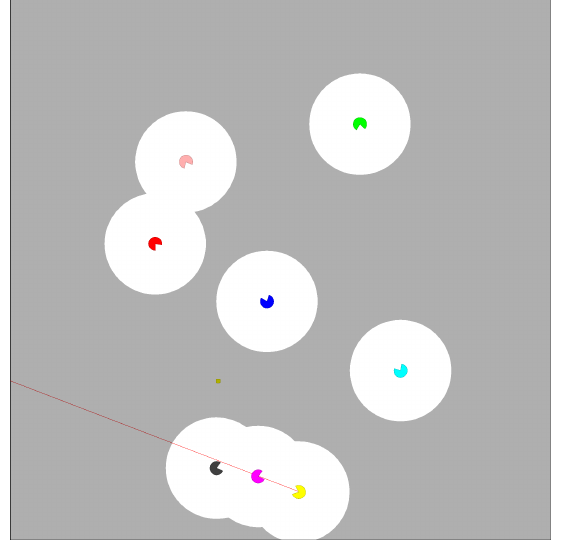
Fig. 1. In the Pakuhaku game, eight players try to collect as many pills as possible from the playing field. Pills are dispensed to the game world one pill at a time. A new pill is added to a random location every time a pill is collected. The game ends when the players have collected 64 pills in total, and the winner is the player with most pills. The game world has a size of 800 × 800 units and all players start at the centre of the world. The players are modelled as circles with a radius of 10, units and they can move 5 units per turn to any direction. The pills are modelled as circles with a radius of 3 units. The field of view has a radius of 75 units. The players can shoot each other once every 20 turns with a ray that freezes the target for 10 turns. T EST S